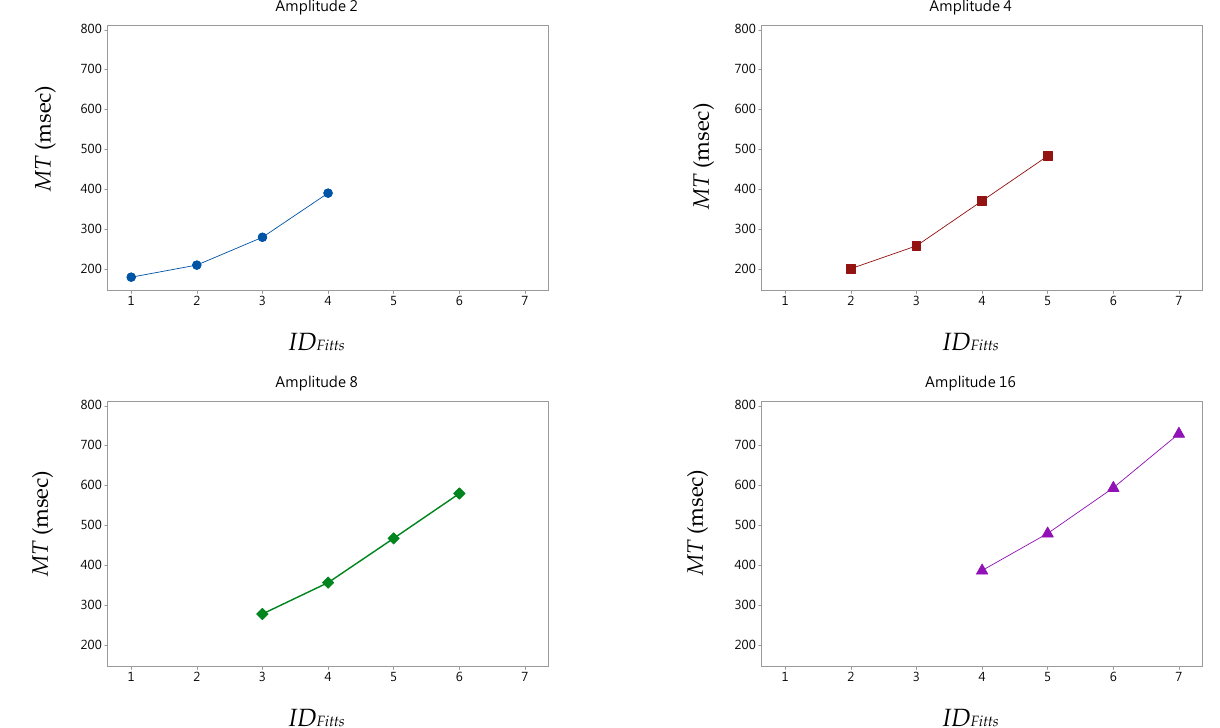
Figure 4. Movement time vs. ID Fitts in the 1 oz stylus tapping task with the same amplitude. All the plots show upward curves, which cause the PRESS to be much worse than the SSE.